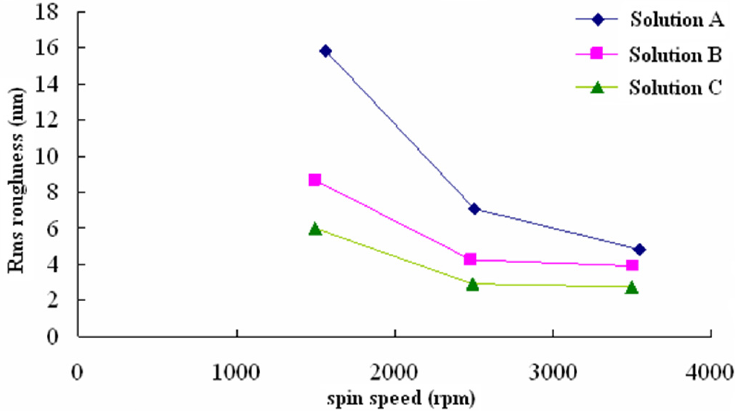
Figure 3. Film roughness results for different spin speed and viscosity scenarios. Film roughness depends on solution viscosity and spin speed, decreasing with increasing spin speed and/or decreasing viscosity. Film roughness was 2.762 nm for a spin speed of 3500 rpm using Solution C (with lowest viscosity). Roughness was measured using AFM.